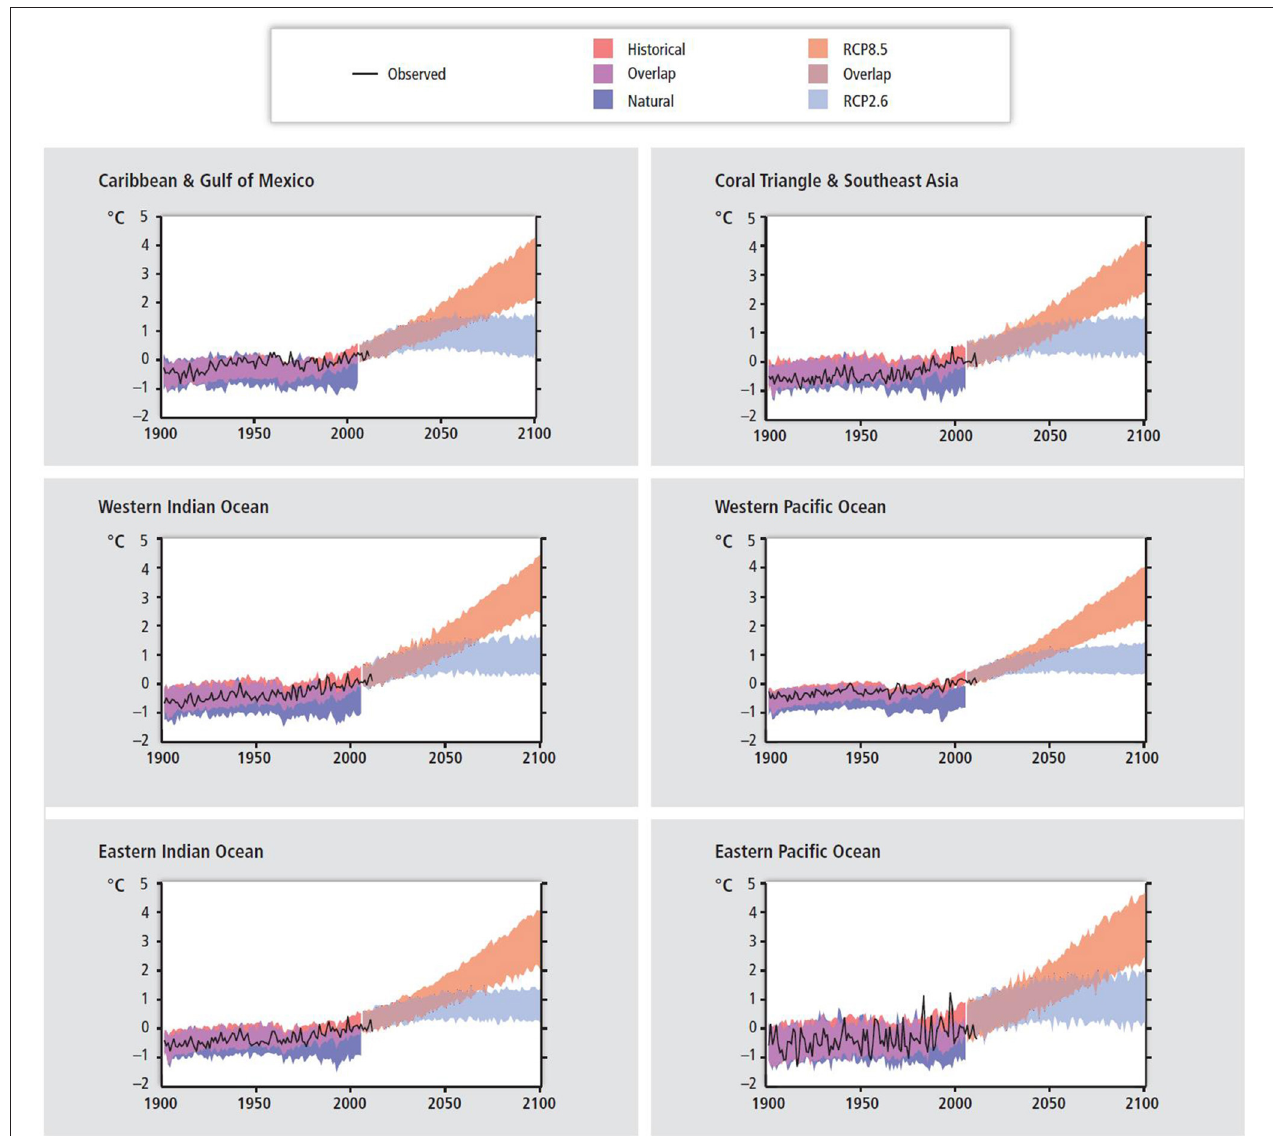
FIGURE 6 | Past and future sea surface temperatures (SST) in six major coral reef provinces and locations (Figure 1B) under historic, unforced (natural), and Representative Concentration Pathways (RCP)4.5 and 8.5 scenarios from Coupled Model Intercomparison Project Phase 5 (CMIP5) ensembles (see Table SM30-3 in Hoegh-Guldberg et al., 2014). Observed and simulated variation in past and projected annual SST over various sites where coral reefs are prominent ecosystems. The black line shows estimates from the Hadley Centre Interpolated sea surface temperature 1.1 (HADISST1.1) data set (Rayner et al., 2003) reconstructed historical SST dataset. Shading denotes the 5–95 percentile range of climate model simulations driven with “historical”changes in anthropogenic and natural drivers (62 simulations), historical changes in “natural” drivers only (25), the RCP4.5 emissions scenario (62), and the RCP8.5 (62). Data are anomalies from the 1986 to 2006 average of the HADISST1-1 data (for the HadISST1.q time series) or of the corresponding historical all-forcing simulations. Figure SM30-3 with the permission of IPCC AR5 (Hoegh-Guldberg et al.,